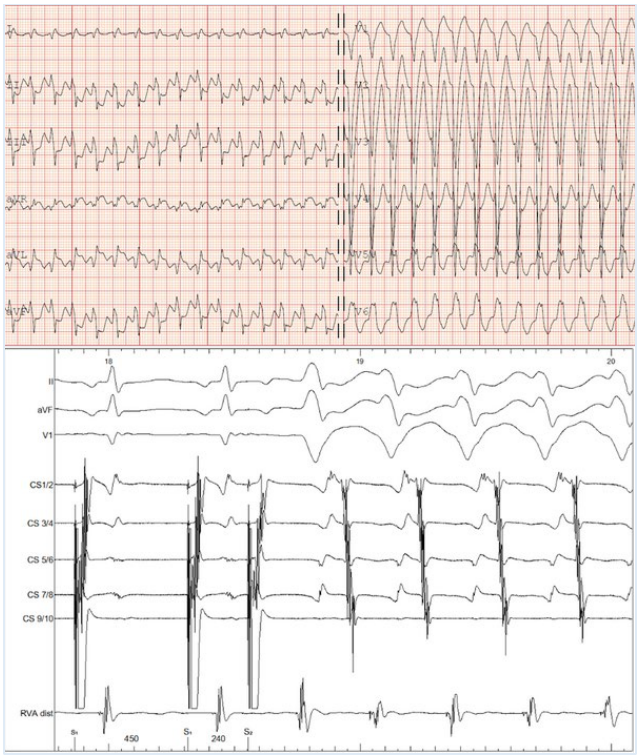
Graph 1: Upper panel 12-lead ECG of the tachycardia. Lower panel Stim- ulation from CS 9/10 with initiation of the tachycardia. II, aVF, V1: Surface leads. CS: decapolar coronary sinus catheter. RVA: quadripolar right ven- tricular